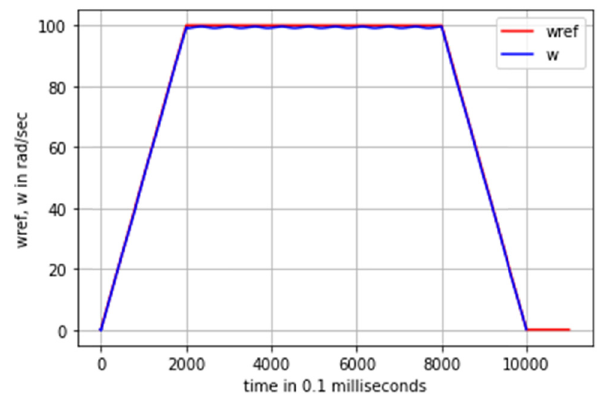
Figure 9: Response of PID control system to disturbance magnitude of 3 × 10 − 2